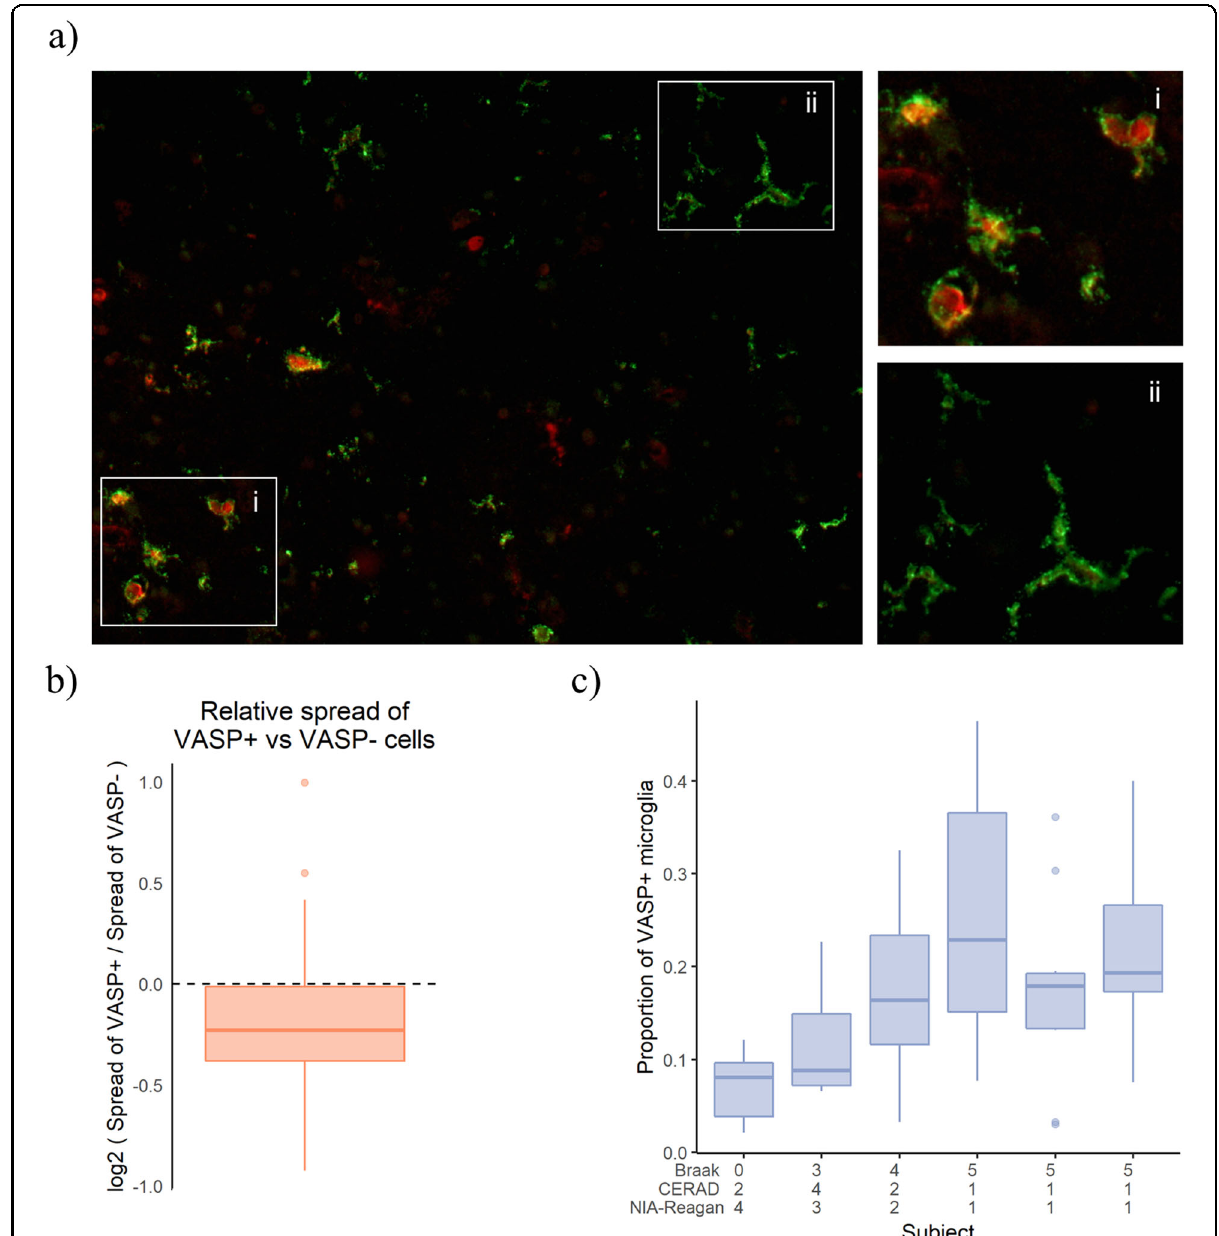
Fig. 4 Immuno fl uorescence reveals VASP + TMEM119 + cells have activated morphology. a Representative micrograph showing co- immunostaining of VASP (red) and TMEM119 (green) in DLPFC. Please note the less rami fi ed morphology of TMEM119 + /VASP + cells (inset “ i ” ) when compared to TMEM119 + /VASP − cells (inset “ ii ” ). b Comparison of cellular morphology ( “ compactness ” is used to quantify the level spread or rami fi cation) between VASP + and VASP − microglia cells (TMEM119 + ) for each of the six tested subjects that were analyzed. Overall, a random- effects model integrating data from all six subjects and a total of 4,158 TMEM119 + cells measured demonstrates that VASP-positive microglia are signi fi cantly less rami fi ed when compared to VASP-negative microglia ( P = 3 × 10 − 8 , β = − 0.26). c The proportion of TMEM119 + /VASP + to TMEM119 + /VASP − relative to Braak, CERAD, and NIA-Reagan scores in six subjects. Linear regression provides evidence that the proportion of VASP- positive microglia increases with Braak score ( P = 0.012, β = − 26.17). DLPFC dorsolateral prefrontal cortex, VASP vasodilator-stimulated phosphoprotein, TMEM119 transmembrane protein 119, a pan-microglia